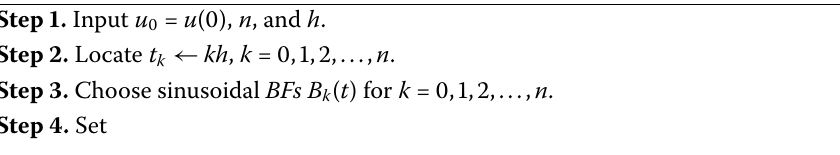
Algorithm  An approximation algorithm for the n partition of [, t n ] with sinusoidal F -